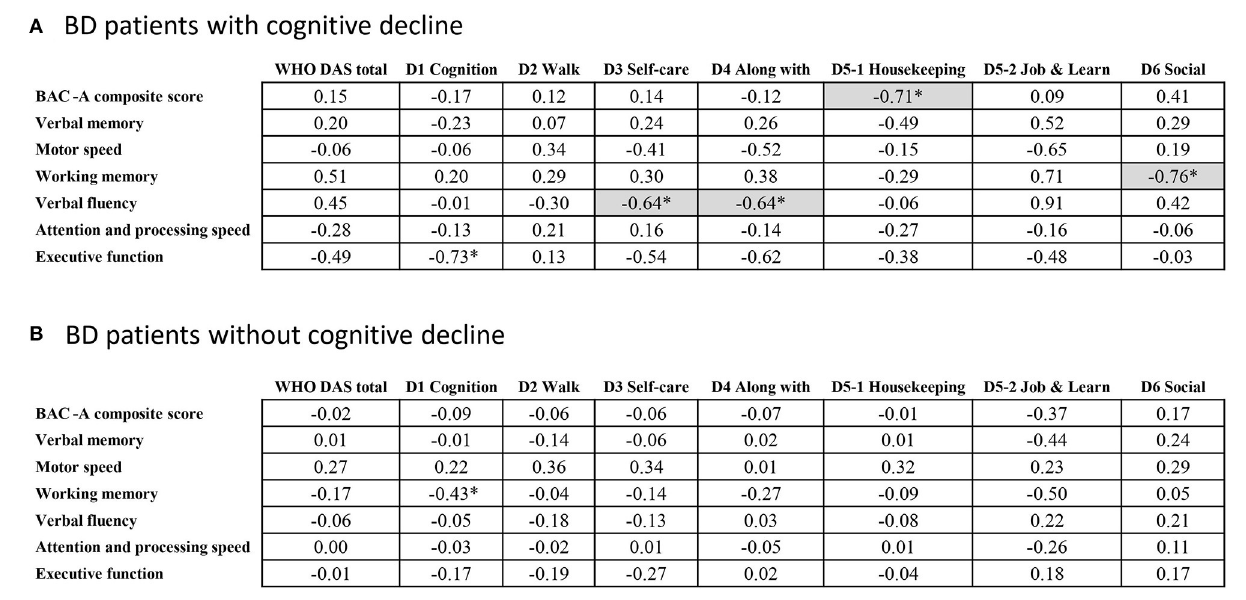
FIGURE 2 | Pearson correlations between cognitive and functional domains in BD. * p < 0.05; Gray base indicating the significance after adjusting the effect of